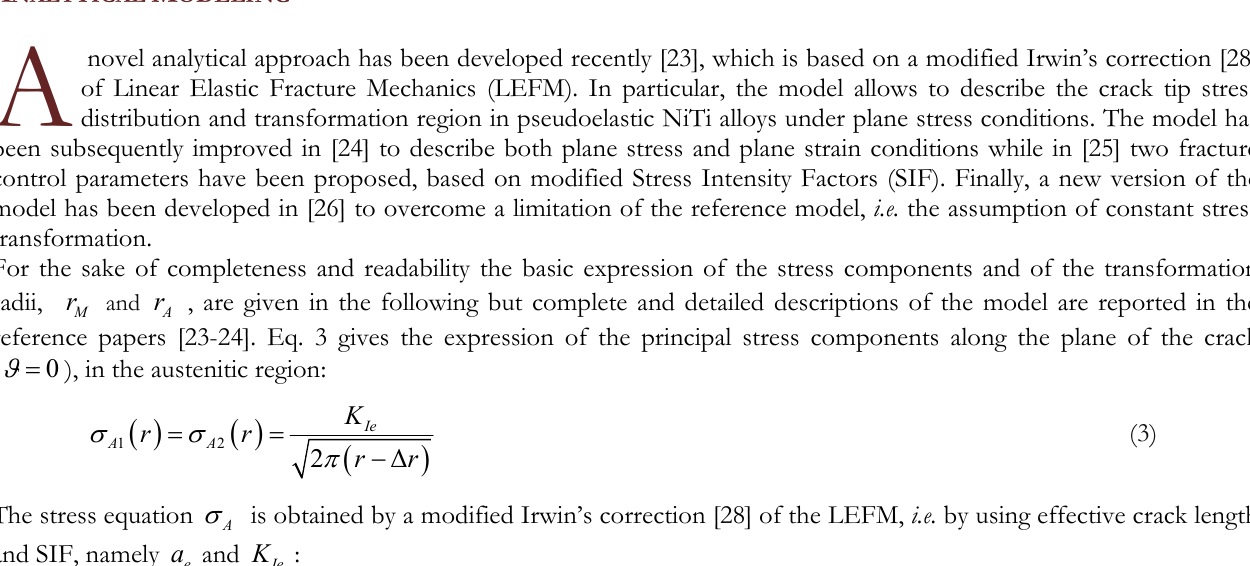
Figure 3: FE results of the crack tip transformation behavior in a pseudoelastic SMA: a) contours of the martensite fraction ( r and r ) as a function of the testing temperature b) transformation radii ( M A